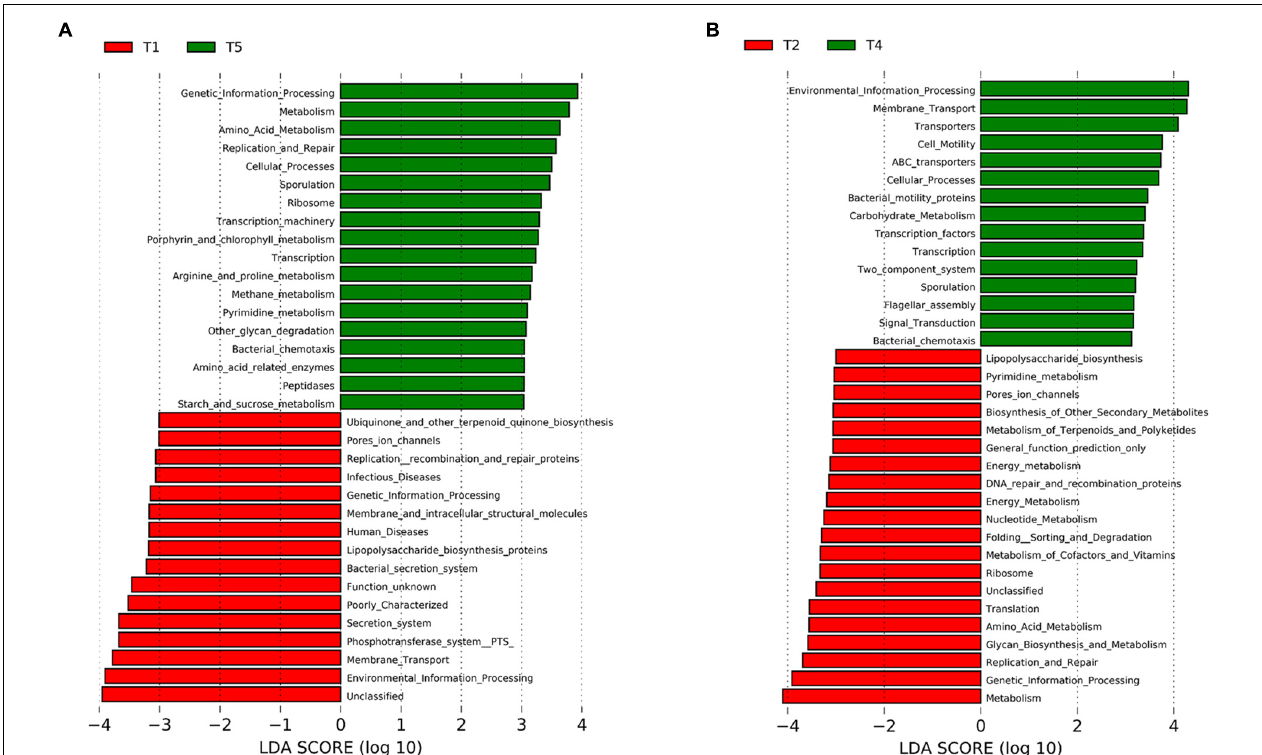
FIGURE 4 | Metagenomic prediction of gut microbiota of dysbiosis-induced mice upon pro-/synbiotics after pathogen Escherichia coli infection. Microbial functions were predicted using PICRUSt at the third level of the KEGG pathway. LEfSe analysis was represented as histogram determining synbiotics LP/P/PPN effect (LDA score > 3.0) (A) and NP PPN effect (LDA score > 3.0) (B)